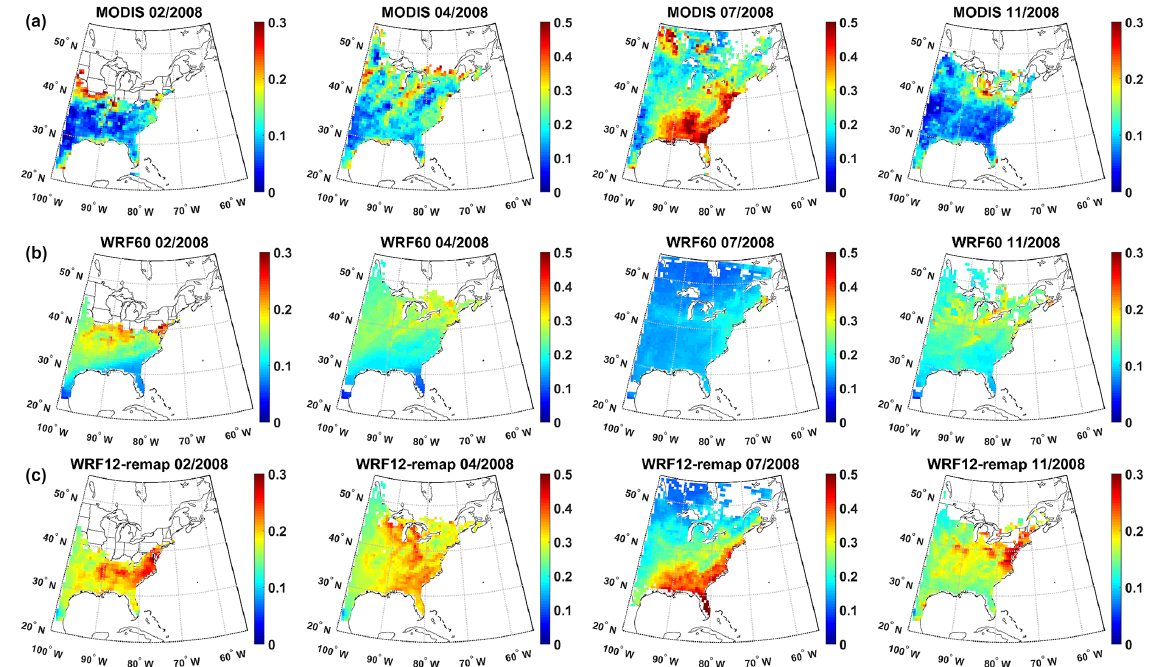
Figure 3. Monthly mean AOD at a wavelength ( λ) of 550nm from MODIS (first line) and WRF-Chem at different resolutions (WRF60 and WRF12-remap, second and third line) during a representative month in each climatological season (columns). Note that a different color scale is applied for different months. For a monthly mean value for a grid cell to be shown, there must be at least five simultaneous daily values (for the time of the satellite overpass)